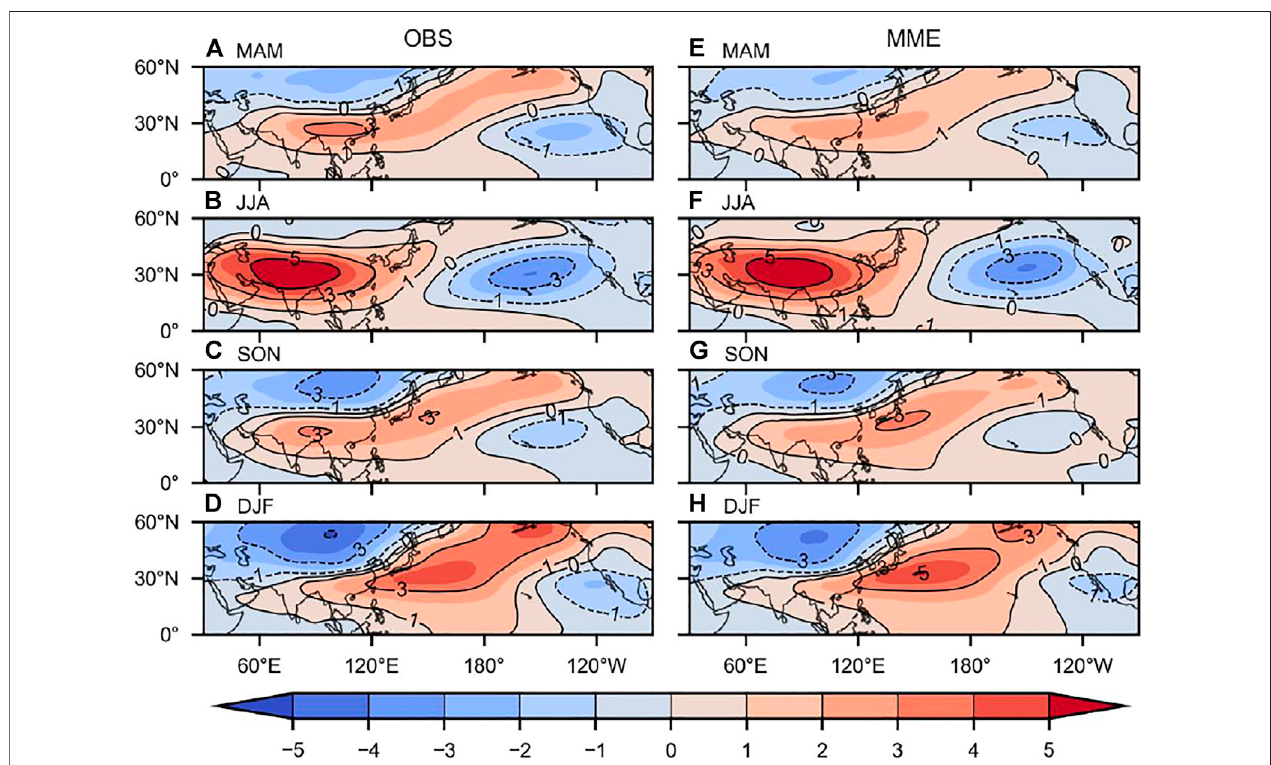
FIGURE 2 | Climatological distribution of (A,E) spring, (B,F) summer, (C,G) autumn and (D,H) winter UTT (unit: ° C) during 1965 – 2014 from (A – D) NCEP/NCAR reanalysis and (E – H) MME simulation.